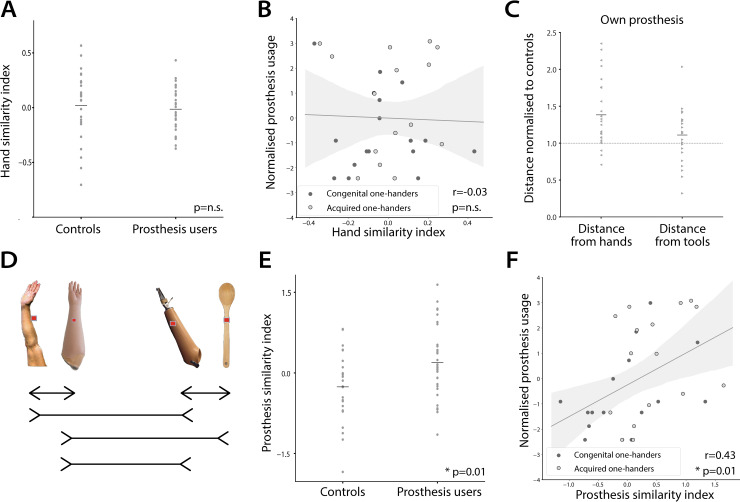
Assessing the embodiment and categorisation hypotheses.(A–B) A hand similarity index was calculated for each participant to quantify the degree to which both prostheses conditions (cosmetic and active) are more similar to hands than tools. A higher index in value indicates greater embodiment (hand similarity of prostheses). (A) A group comparison of the hand similarity index between controls and prosthesis users showed no significant differences (t(54) = 0.47, p = 0.64). Horizontal lines indicate group means and dots indicate individual participants. (B) Correlation between the hand similarity index and prosthesis usage was not significant across users (Pearson’s r(30) = −0.03, p = 0.86). Dark/light circles indicate congenital/acquired one-handers, respectively, and grey shading indicates a bootstrapped 95% confidence interval. (C) Hand (left) and tool (right) distances from users’ ‘own’ prosthesis. Individual distances were normalised by the controls’ group mean distance, depending on the visual features of the ‘own’ prosthesis (hand likeness). A value of 1 indicates similar hand/tool distance to controls’. Users showed significantly greater distances between their own prosthesis and hands (t(25) = 4.33, p < 0.001) contrary to the embodiment hypothesis. Together, these findings demonstrate that hand similarity under the embodiment hypothesis does not adequately explain differences in prosthesis representation in users’ OTC. (D–F) A prosthesis similarity index was calculated for each participant to quantify the degree to which the prostheses representation moved away from their natural categories (hands for cosmetic prostheses and tools for active prostheses) and towards one another. (D) A visual illustration of the prosthesis similarity index formula. Arrows pointing outward indicate distances that should grow in users compared to controls (e.g., hands and cosmetic prostheses) and are therefore positively weighted. Arrows pointing inward indicate distances that should shrink in users compared to controls (i.e., cosmetic and active prostheses) and are therefore negatively weighted. (E) Group comparison of the prosthesis similarity index between controls, and prosthesis users showed greater prosthesis similarity in users (t(54) = −2.55, p = 0.01). (F) The prosthesis similarity index significantly correlated with prosthesis usage; higher prosthesis index associated with greater prosthesis usage (based on wear frequency and skill; Pearson’s r(30) = 0.43, p = 0.01). Together, these findings demonstrate the categorisation hypothesis explains differences in user’s prosthesis representation in the OTC, both with respect to controls and interindividual prosthesis usage. Data used to create this figure can be found at https://osf.io/4mw2t/. n.s., no significance; OTC, occipitotemporal cortex.